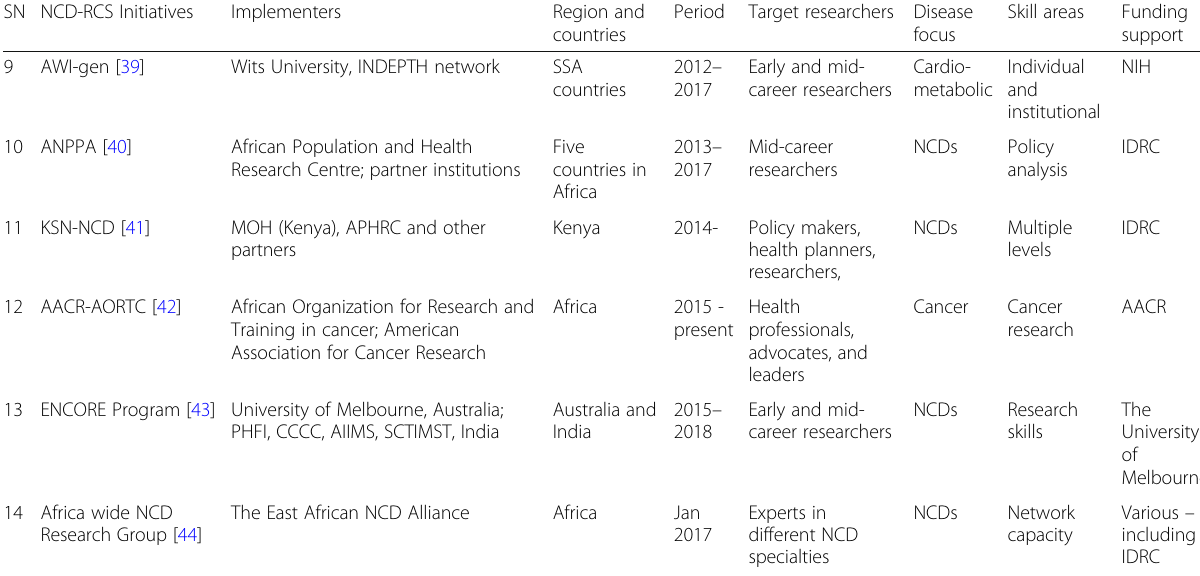
Table 1 Characteristics of NCD-RCS initiatives included in this study (Continued) SN NCD-RCS